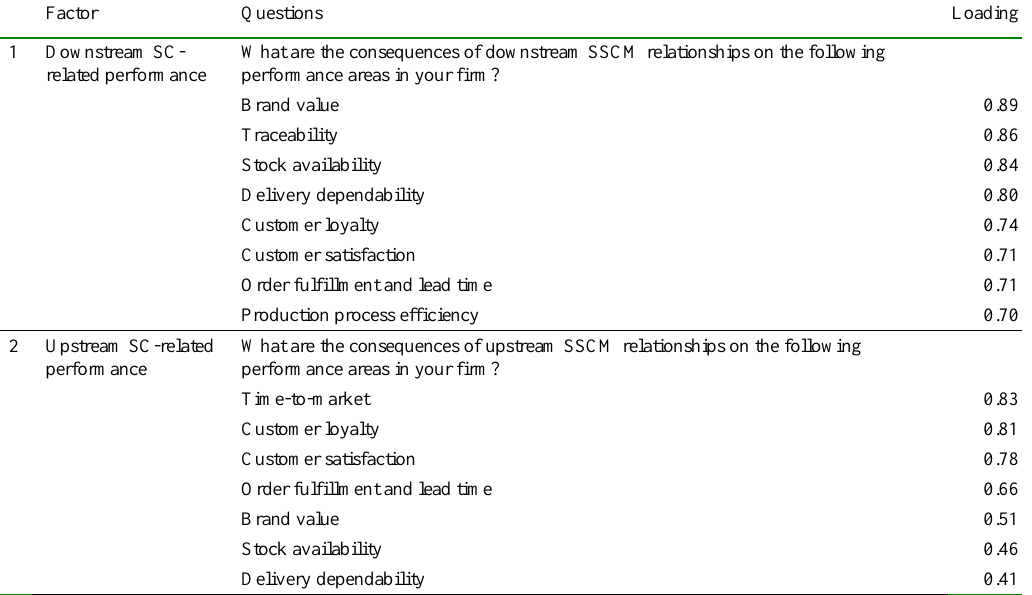
Table 3 : Factors Characterizing Performance Consequences of SSCM